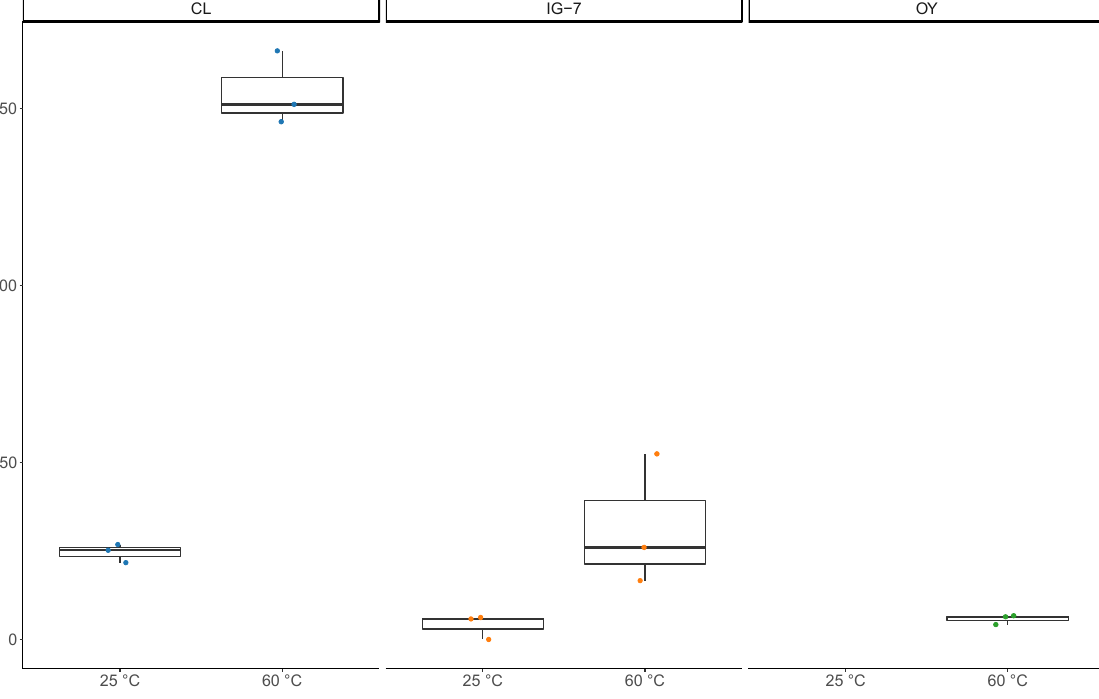
Figure 1. Box and whisker plot representation of CO uptake rates ( µ mol gdw − 1 d − 1 ) for each temperature (25 ◦ C and 60 ◦ C) at each site (CL, IG-7, and OY) with 25% CO. Median values are indicated by solid bars. Data not present (OY 25 ◦ C) indicate no CO uptake.